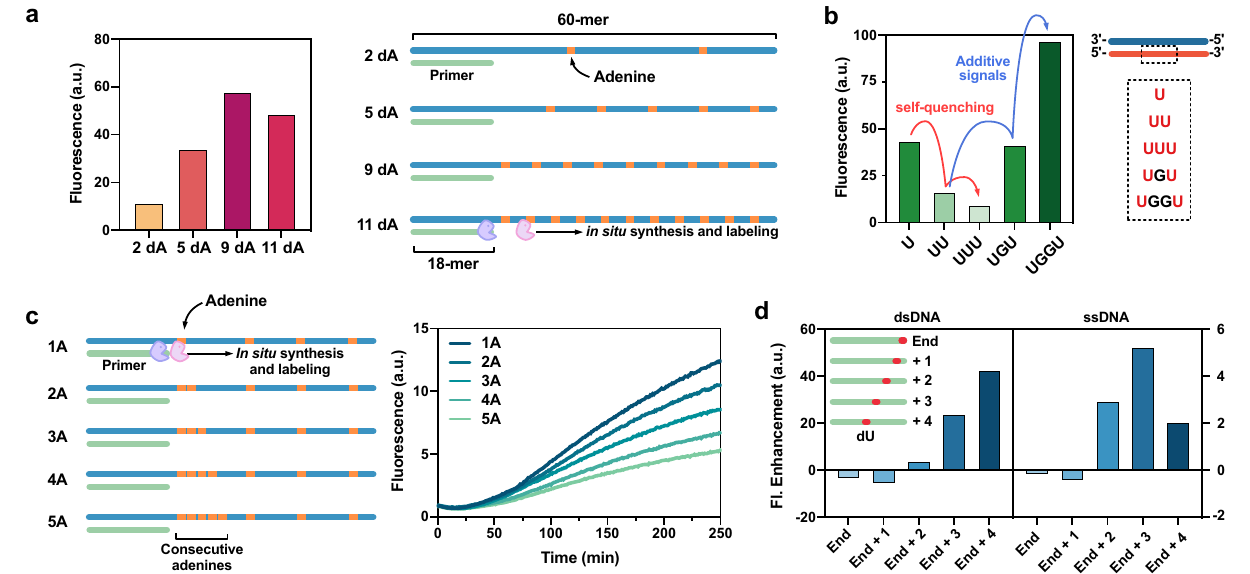
Fig. 2 | Optimization of labeling frequency. a Fluorescence intensity depending on the number of labeling sites in ODNs after 1000min of reaction. b Fluorescence intensities of different numbers of CCVJ-1 in varied distances. c Fluorescence enhancement during the in situ synthesis and BETr labeling with the templateODNswithconsecutive dA. d Fluorescence enhancement measured